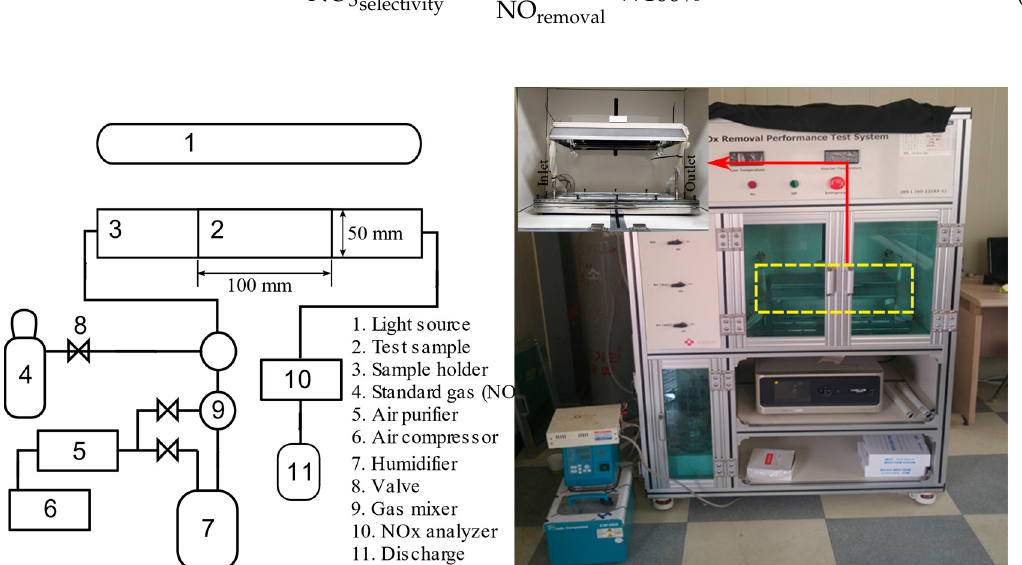
Figure 8. The schematic of the experimental setup ( left ) along with the photo of the experimental setup ( right ) for photocatalytic NO removal under UV and visible light irradiance.